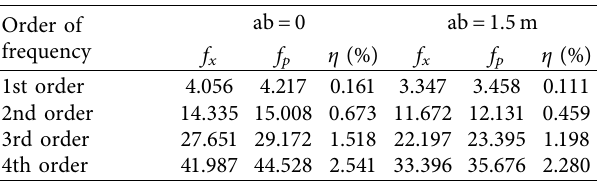
Table 5: Comparison of vibration frequency values of composite box girder with different cantilever lengths (Hz). Order